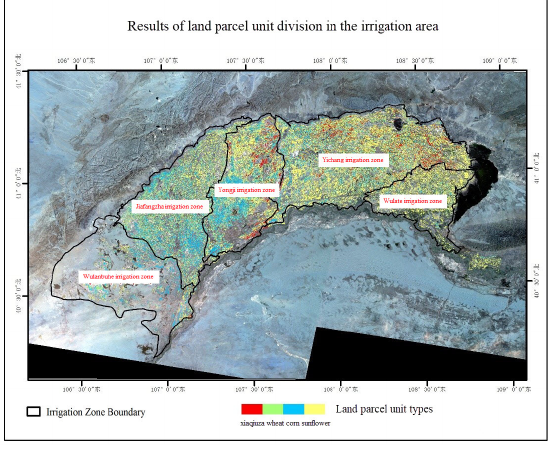
Figure 6. Land parcel unit division results in Hetao Note: Hetao irrigation area is divided by five irrigation zones including Jiefangzha, Wulate, Wulanbuhe, Yichang, Yongji